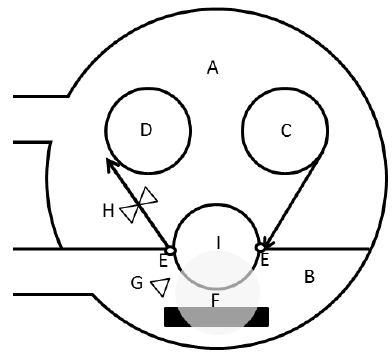
Figure 1. Basic construction of a vacuum deposition chamber (adapted from [1]).